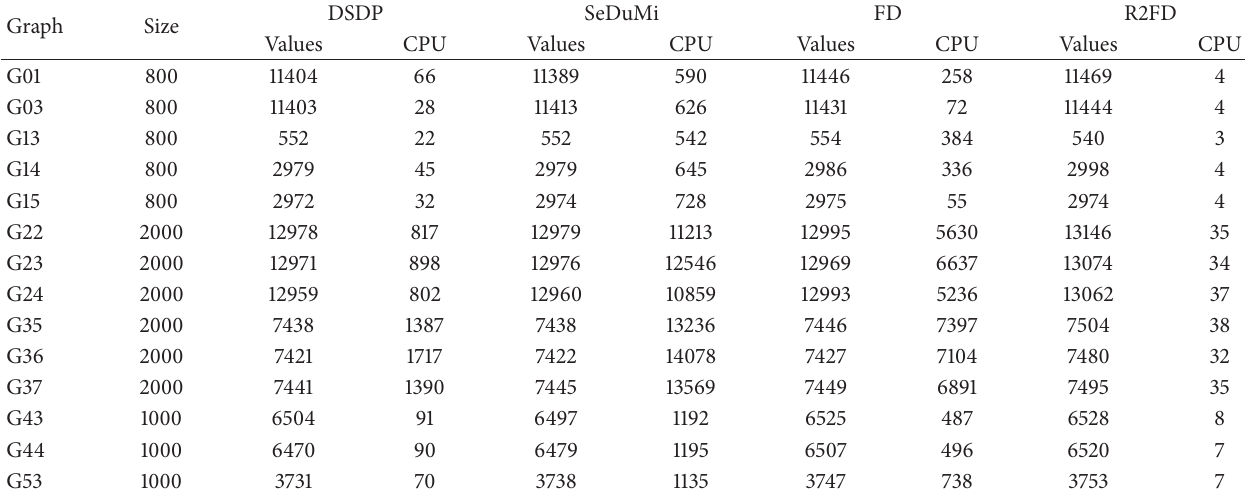
Table 2: Comparison results for G-set